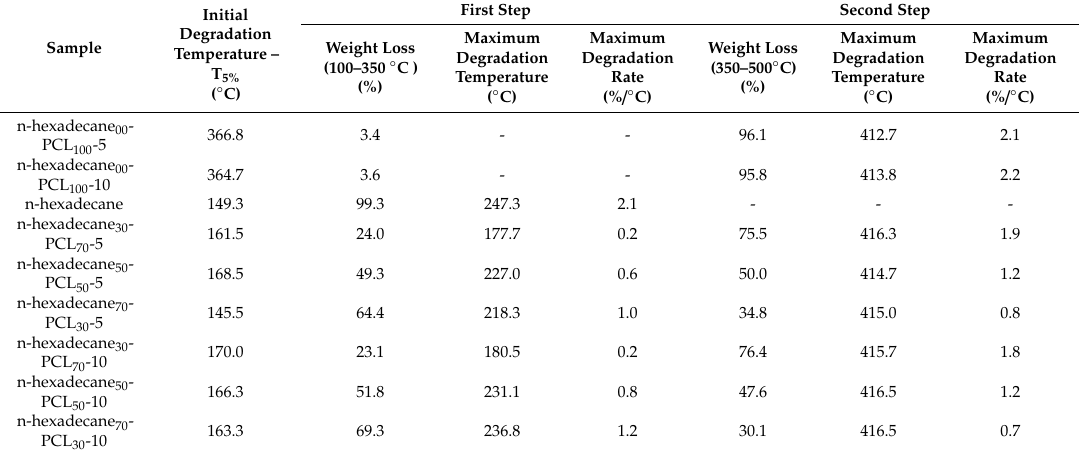
Table 4. Thermogravimetric data of raw n-hexadecane, neat PCL microparticles and a series of n-hexadecane / PCL microcapsules obtained from two PCL concentrations with di ff erent loading ratios between n-hexadecane and